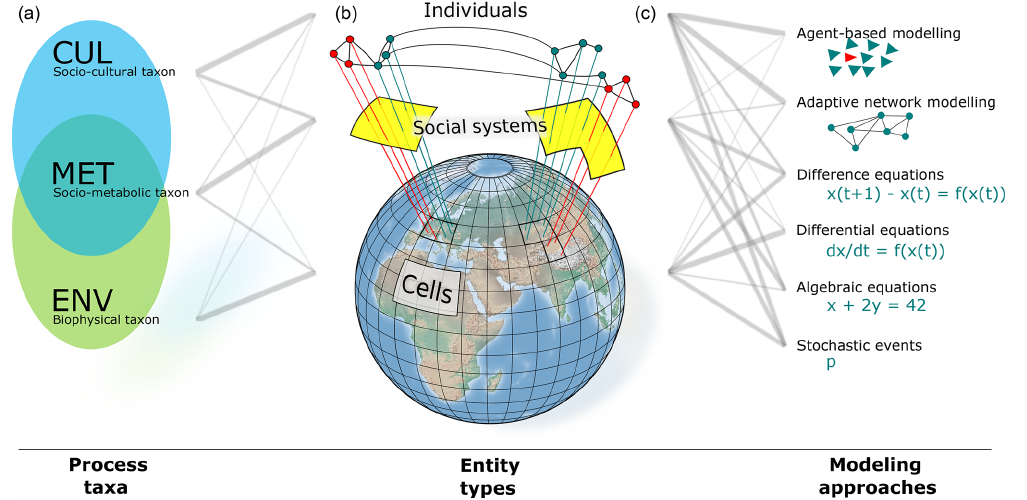
Figure 2. Overview of the copan:CORE open World–Earth modeling framework. The entities in copan:CORE models are classified by entity types (e.g., grid cell, social system, individual; see b ). Each process belongs to either a certain entity type or a certain process taxon (a) . Processes are further distinguished by formal process types (see text for a list), which allow for various different modeling approaches (c) . Entity types, process taxa and process types can be freely combined with each other (gray lines). Thick gray lines indicate which combinations are most common. The copan:CORE framework allows us to consistently build world–Earth models across the spectrum from stylized and globally aggregated to more complex and highly resolved variants in terms of spatial and social structure. Hence, entity types, process taxa and types may or may not be present in specific models. For example, a stylized and globally aggregated model would describe the dynamics of the entity types “world” and “social system” and contain neither cells nor individual agents as